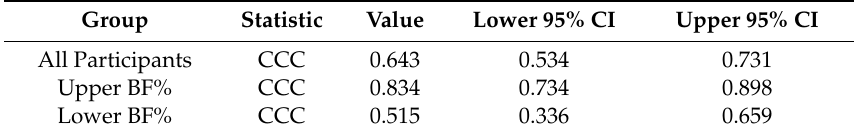
Table 6. Subgroup concordance correlation coe ffi cients (with 95% CI).